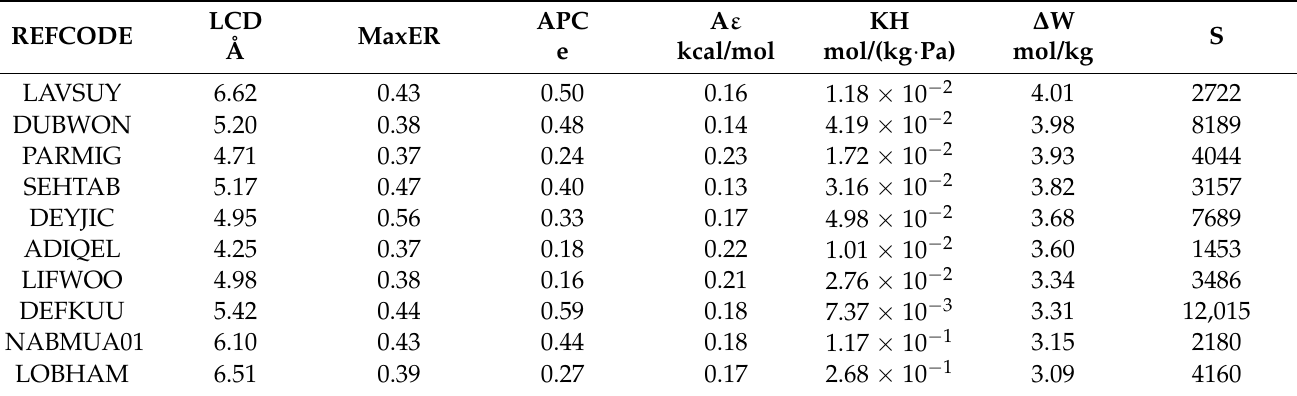
Table 1. The largest cavity diameter (LCD), maximum explained ratio (MaxER), average positive charge (APC), average ε (A ε ), Henry’s constant (KH), working capacity ( Δ W) and selectivity (S) of the top 10 MOFs.